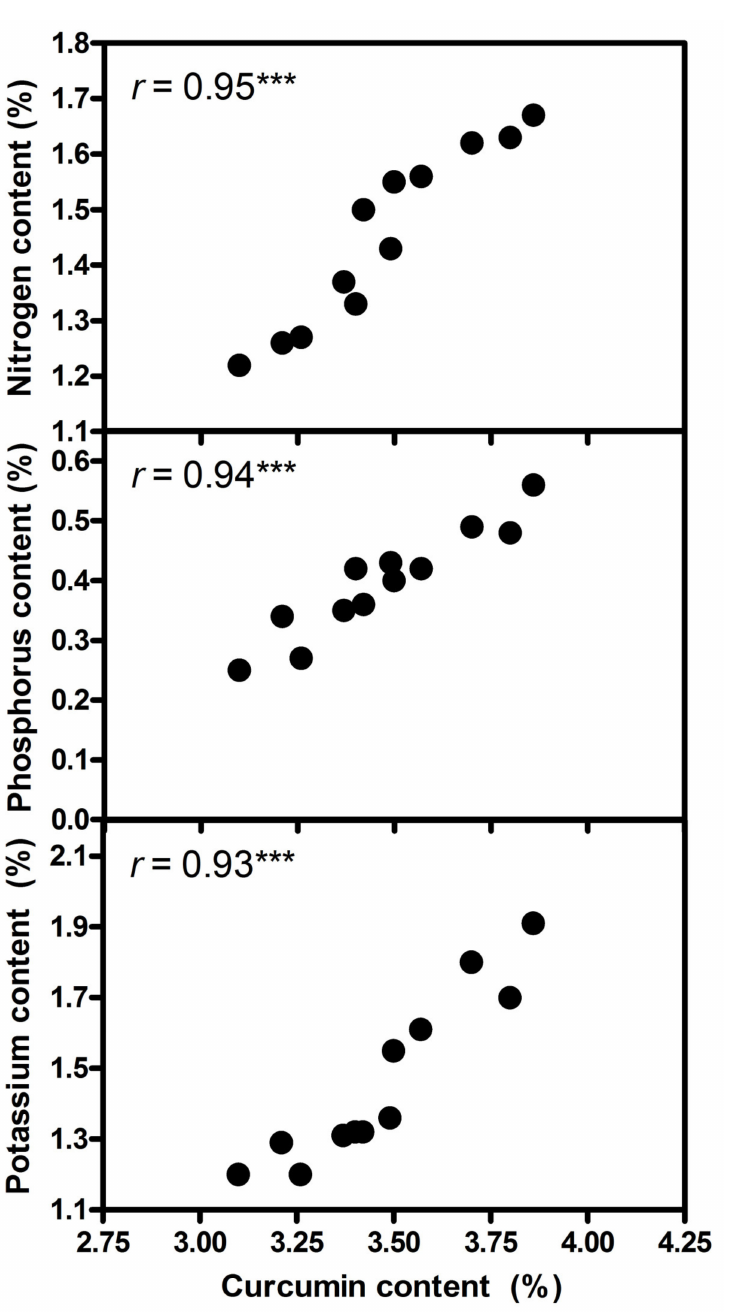
Figure 6. Coefficient correlation of curcumin content and nitrogen, phosphorus and potassium contents. *** Significance at probability level of <